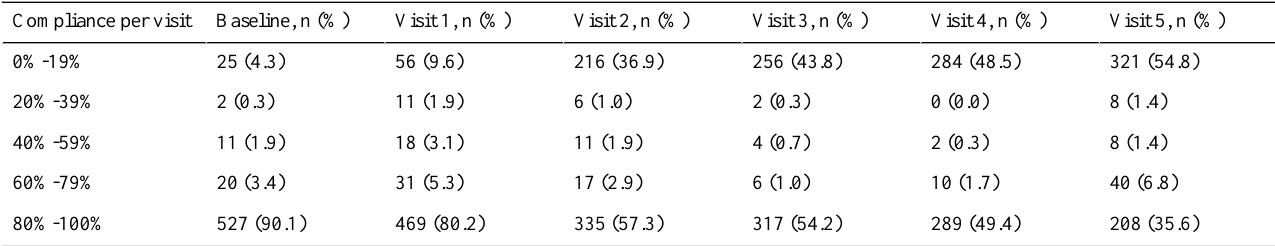
Table 3. Completion rates per visit in relation to the number of participants per